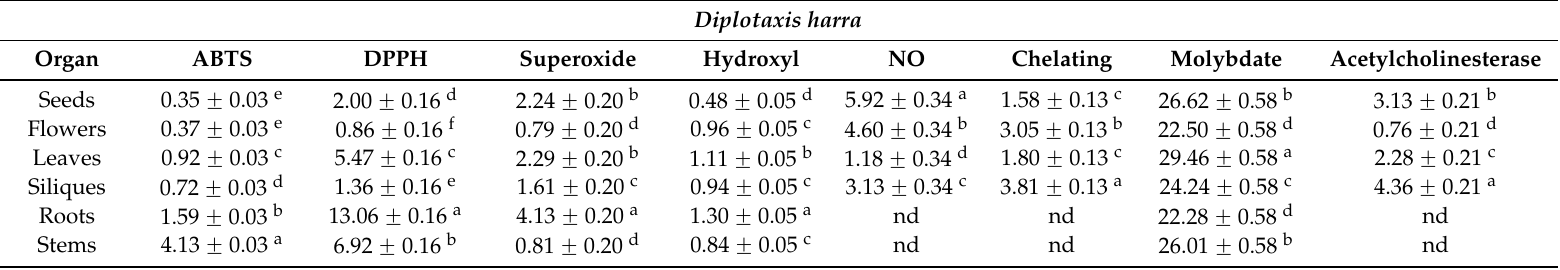
Table 3. Antioxidant activities of plant extracts of D. harra expressed in IC 50 (mg/mL) for ABTS, DPPH, superoxide, hydroxyl and NO scavenging activities, chelating activity and acetylcholinesterase inhibitor activity. Total antioxidant activity evaluated through the molybdate method is expressed as mg ascorbic acid equivalent/100 g, dry weight). (Mean ˘ standard